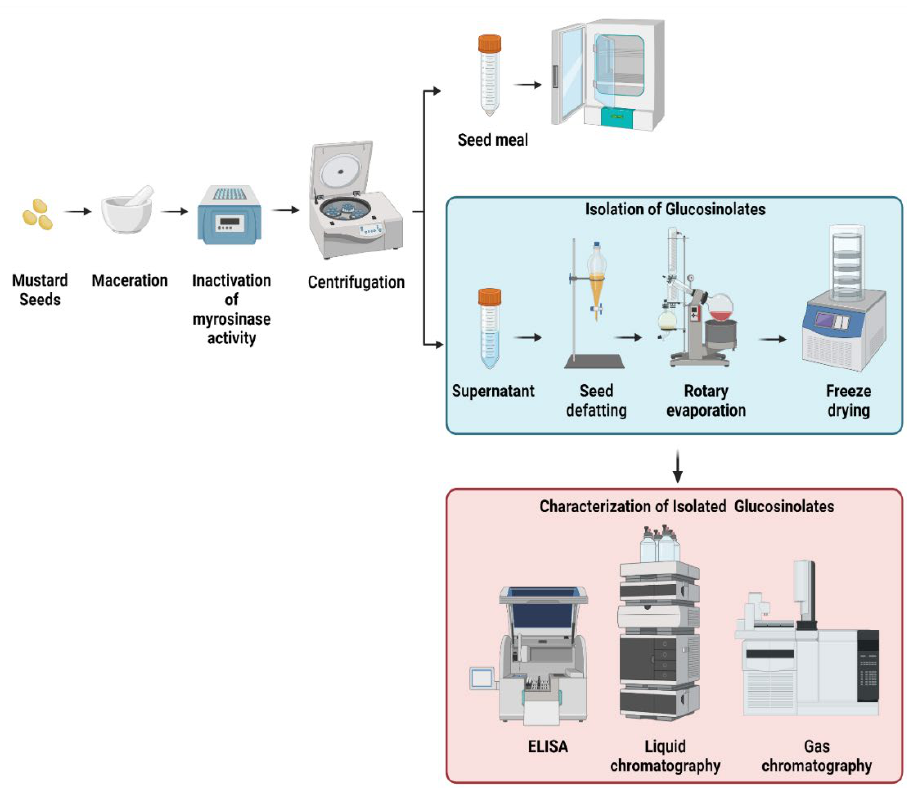
Figure 3. Overview of the extraction, isolation, purification, and structure elucidation of glucosino- lates from the seeds of mustard plants. Created with BioRender.com.